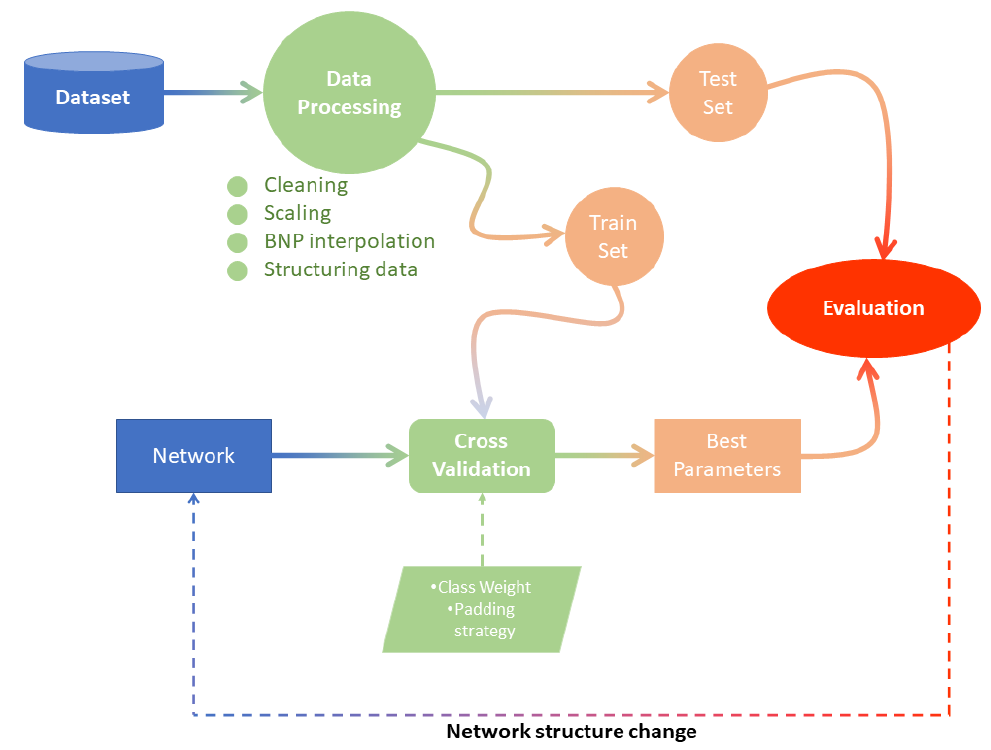
Figure 2. Flow chart of developed